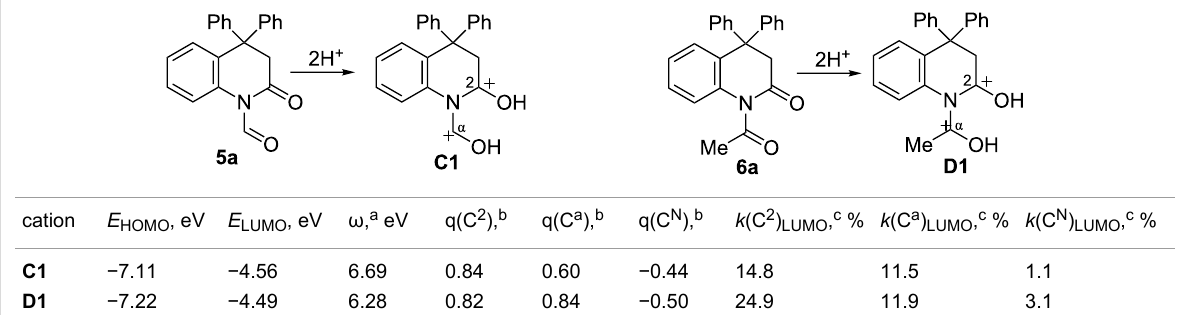
Table 2: Selected electronic characteristics (DFT calculations) of dications C1 and D1 derived from protonation of 5a and 6a , respectively.